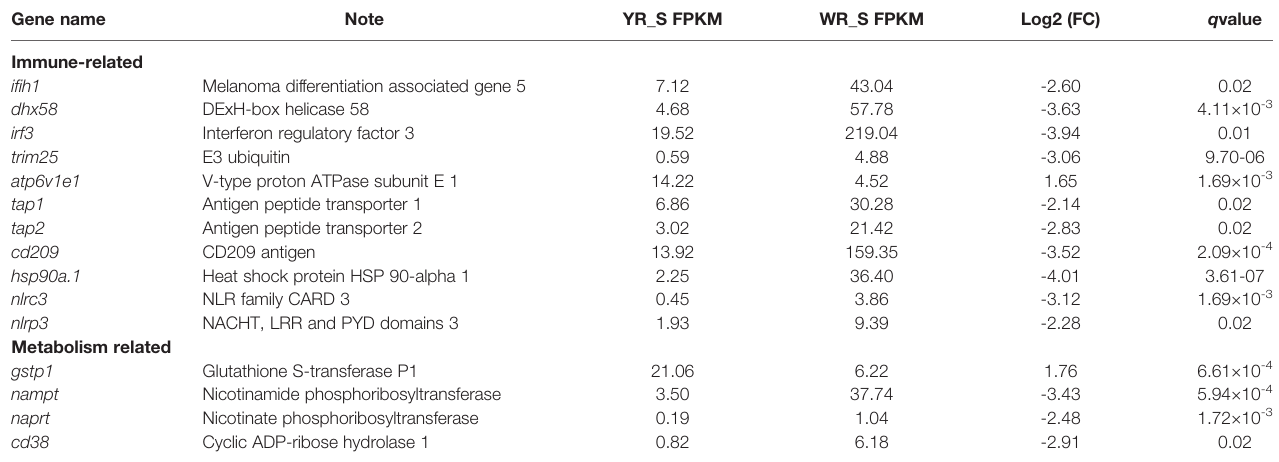
TABLE 1 | Representative immune and metabolism-related genes differentially expressed between wild-type rainbow trout (WR_S) and yellow mutant rainbow trout (YR_S) groups.